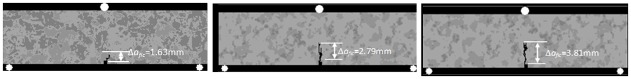
The values of fictitious crack growth Δafic at the peak load under 3-p-b test.(a) Fine grain size = 1.01mm (b) Medium grain size = 2.12mm (c) Coarse grain size = 3mm.